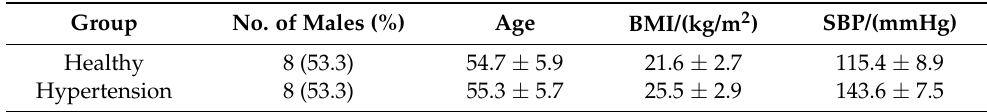
Table 3. Comparison of basic data between two groups of